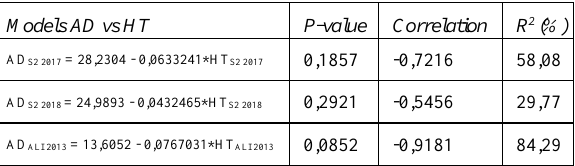
Table 1. Comparison of relationships between spectral